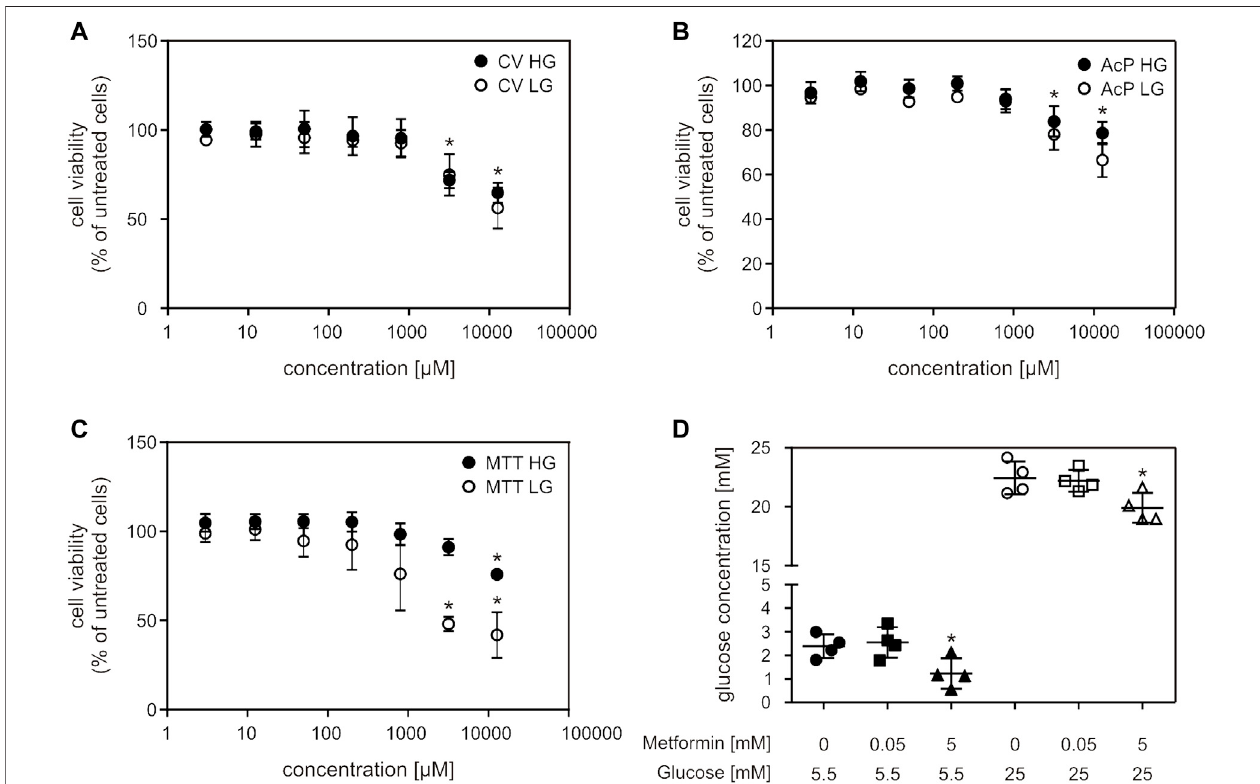
FIGURE 1 | Millimolar metformin concentrations decreased cell viability and glucose concentration in cell medium. C2C12 cells were treated with a wide range of metformin concentrations (3; 12.5; 50; 200; 800; 3,200; 12,800 µM) for 24 h and cell viability was measured byCV (A) ,AcP (B) and MTT (C) assays. Results from three independent experiments (each with six technical replicates) are presented as mean ± SD (A – C) . Glucose concentration in HG and LG cell medium after 24 h of treatment with 50 μ M and 5 mM metformin was measured by Glucose-TR assay (D) . Results from four independent experiments are presented as scatter plots, with mean ± SD (D) , * p < 0.05. MF — metformin, CV — crystal violet, AcP — acid phosphatase, HG — high glucose, LG — low